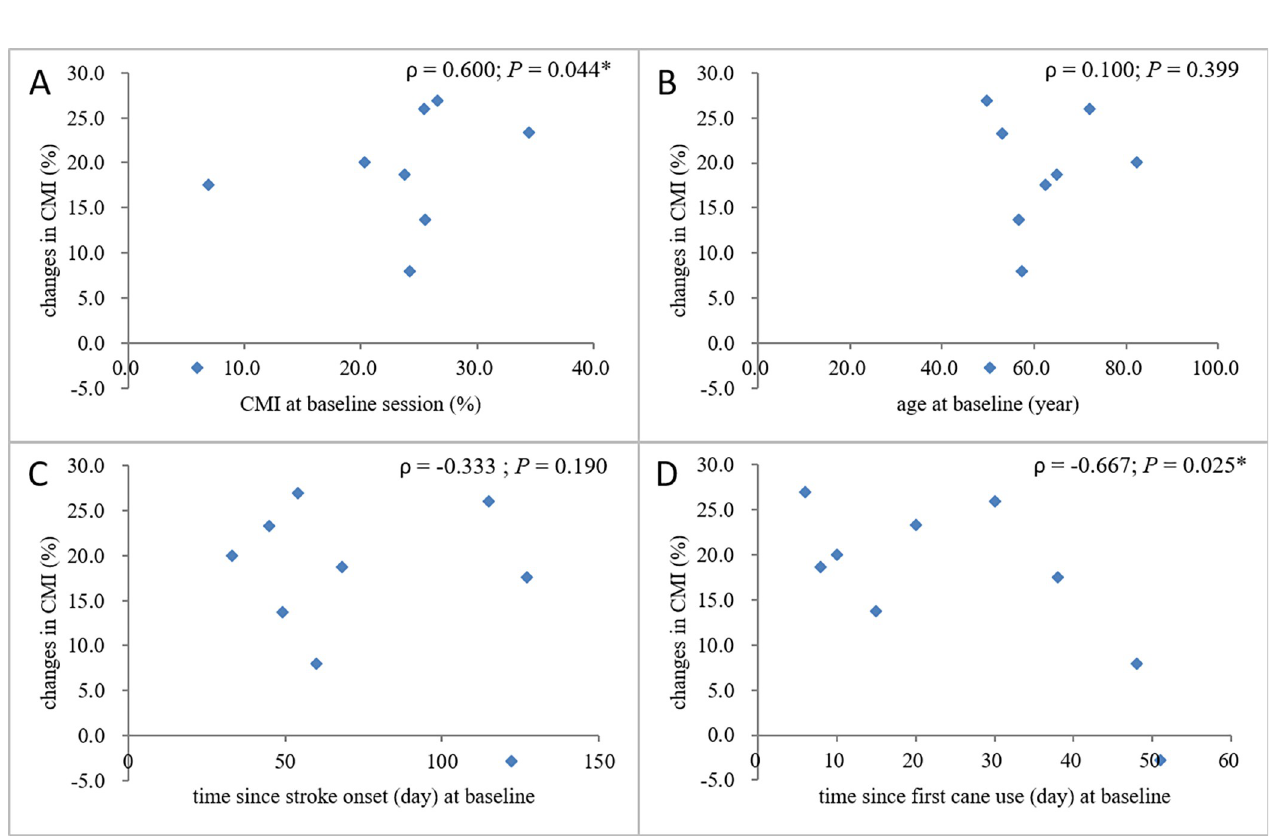
Fig 3. Scatter plots showing the relationship between the change in walking velocity CMI between the baseline and final sessions and (A) CMI at the baseline session, (B) age, (C) time since stroke onset, and (D) time since first cane use. A positive CMI value indicated deterioration due to dual-tasking. The results of the Spearman correlation tests are